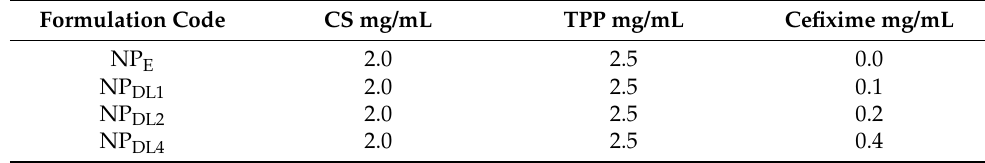
Table 4. Composition of the different empty (E) or drug-loaded (DL) CS NP formulations. Formulation Code